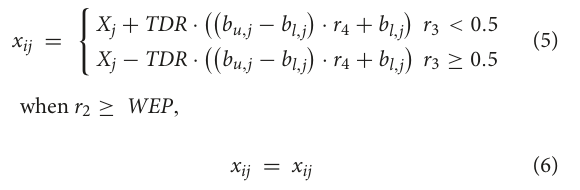
proportion of wormholes in the universe. TDR is the distance between the optimal universe and the object passing through the wormhole